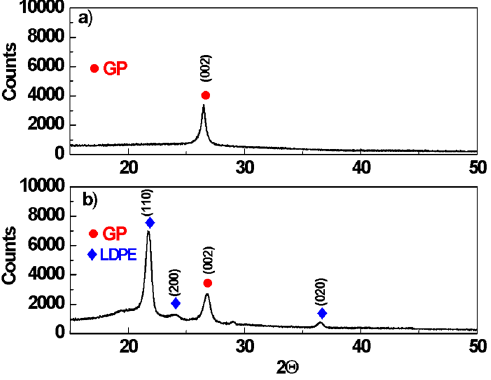
Figure 4. XRD diffractograms of graphite platelet (GP) films deposited on glass ( a ) and LDPE ( b